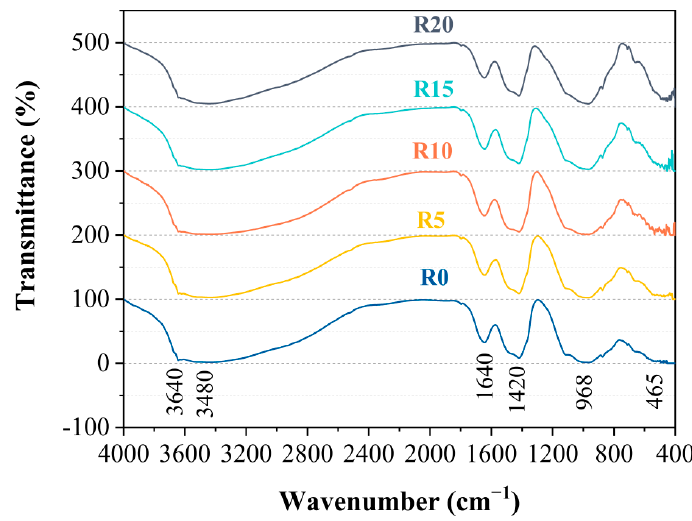
Figure 8. FT-IR spectra of pastes.